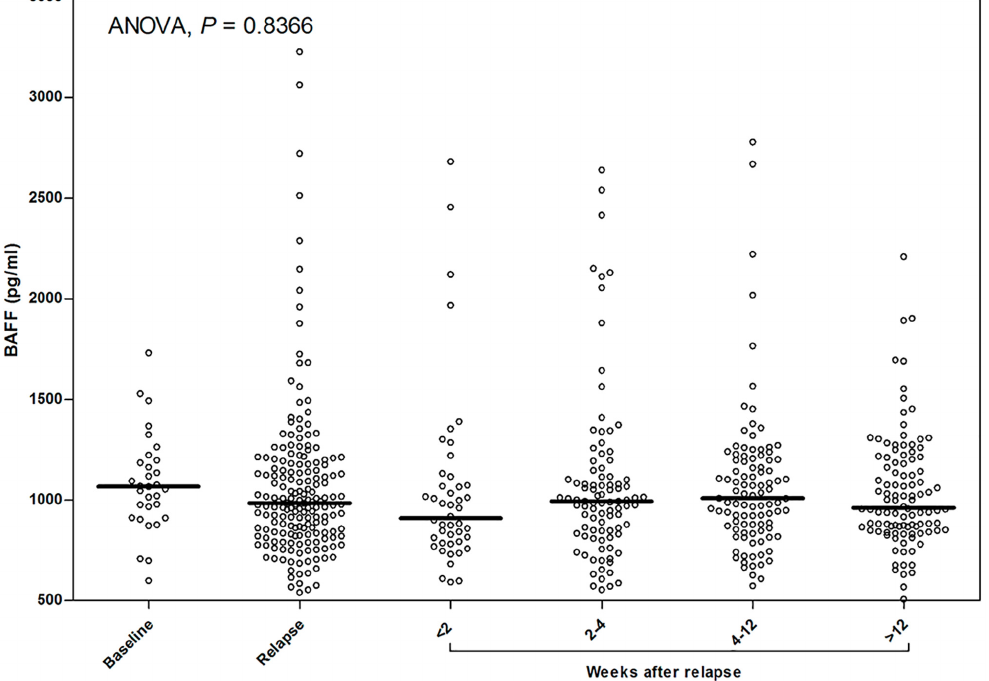
Fig 3. Changes in plasma BAFF levels during follow-up visits in the MS group. Bee Swarm plot and means of BAFF levels at baseline (n = 31), during relapse (n = 186) and 1 – 2 weeks (n = 46), 2 – 4 weeks (n = 93), 4 – 12 weeks (n = 99) or 12 – 24 weeks (n = 104) after the relapse were presented.